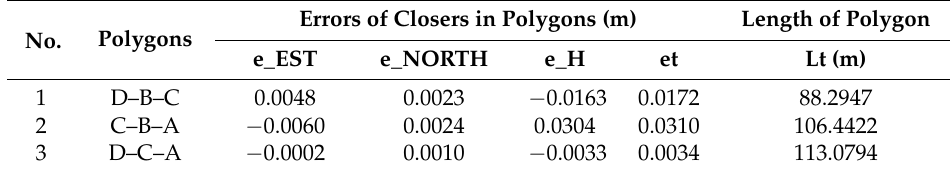
Table 1. The non-closures calculation of GNSS network polygons.